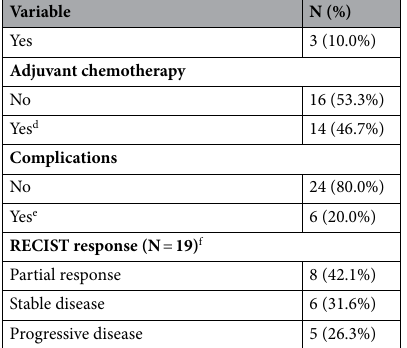
including anastomotic leak from bowel anastomosis. The intra-operative risk–benefit analysis for performing HIPEC was supported by a recent randomized clinical trial showing that HIPEC was not beneficial to survival outcomes for patients with low PCI scores, but increased the risks of complications 17 . For the fourth patient, the PCI score was 30 and the procedure was aborted due to patient instability during the procedure. This patient did not receive neoadjuvant chemotherapy because the pre-operative diagnosis was consistent with disseminated analysis had upgraded the diagnosis to an appendiceal adenocarcinoma. For the remaining 26 patients (86.7%) who received HIPEC, cisplatin and/or mitomycin-C was perfused for 90 min. Three patients received neoadjuvant radiation for gastric adenocarcinoma (1), retroperitoneal dedif- ferentiated liposarcoma (1), and pelvic leiomyosarcoma originating from the left iliac vein (1). Of the 19 patients